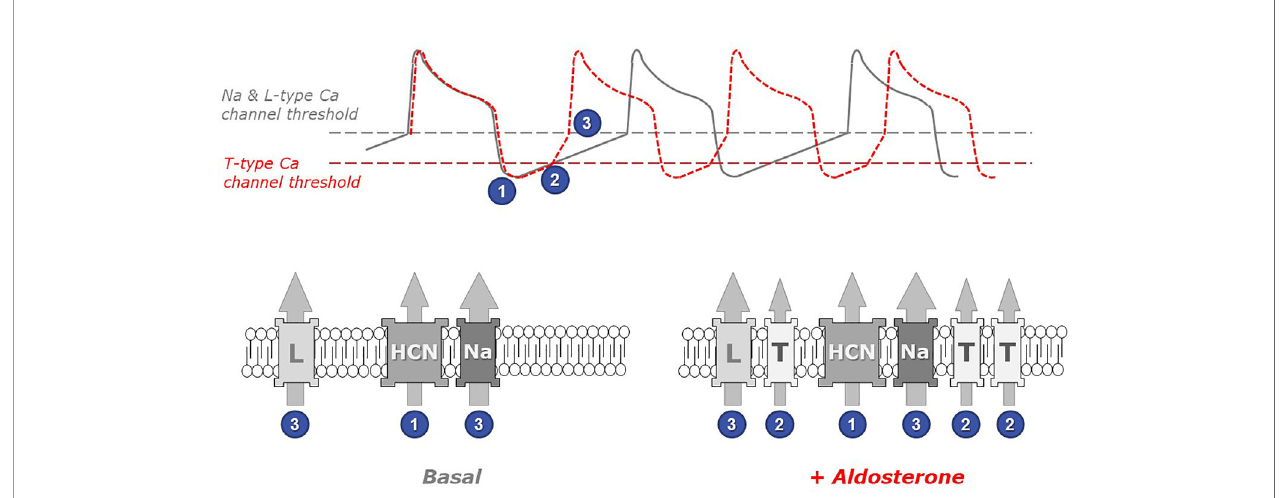
FIGURE 2 | The role of low threshold T-type calcium channels in the chronotropic response to aldosterone. Spontaneous cardiomyocyte beatings are closely linked to action potentials (APs) occurring when the membrane voltage reaches the threshold for Na and L-type Ca channel activation (upper panel, gray line). Under resting (basal) conditions, the frequency of APs depends on the duration of the diastolic depolarization phase (following the transient hyperpolarization occurring at the end of each AP), which is principally controlled by the activity of pacemaker channels such as the HCN channels, which open at very negative voltages (step 1 in fi gure). Upon myocyte stimulation with aldosterone (red line), the presence of low threshold T-type Ca channels in myocyte membranes accelerates the occurrence of APs. Indeed, these channels open early during the depolarization phase (step 2) and therefore contribute to membrane depolarization. Thus, the membrane potential reaches earlier the threshold for triggering the next action potential (step 3). The gray dotted line in the upper panel indicates the voltage at which Na and L-type Ca channels activate, while the red dotted line indicates the (lower) threshold of T-type Ca channel activation. The identity of relevant ionic channels present in cardiomyocyte membranes under basal conditions (left) and in aldosterone-stimulated myocytes (right) is shown in the bottom panels: HCN, hyperpolarization- activated cyclic nucleotide-gated cation non-selective (pacemaker) channel; Na, voltage-activated sodium channel; L and T, high-threshold L-type and, respectively, low-threshold T-type, voltage-activated calcium channels. Numbers indicate at which step each channel